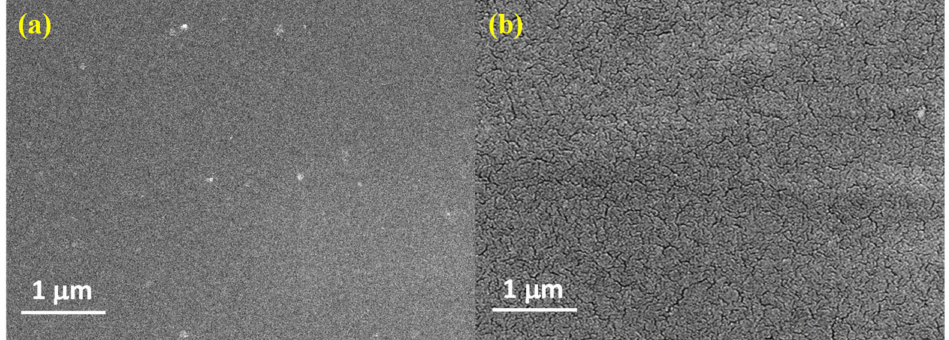
Figure 5. ( a ) Scanning Electron Microscopy (SEM) images of sulfonated poly (1,4-phenylene ether- ether-sulfone) (SPEES) and ( b )